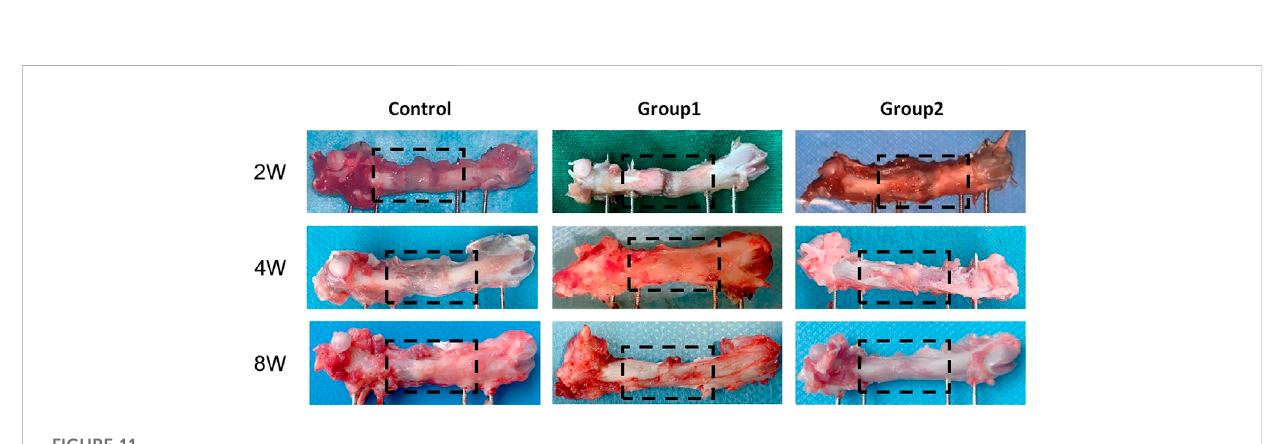
FIGURE 11 General picture of rat